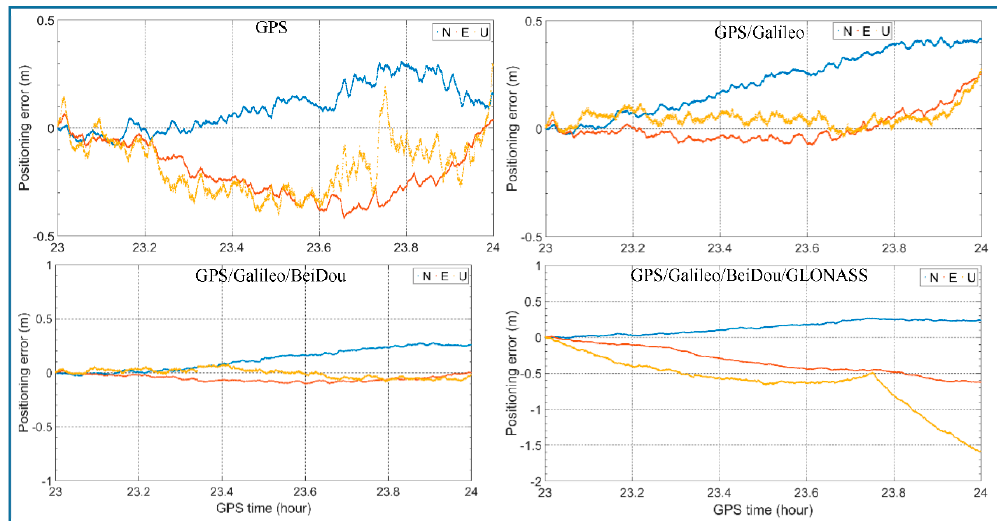
Figure A1. The time-relative positioning errors with different scenarios in 24 h.